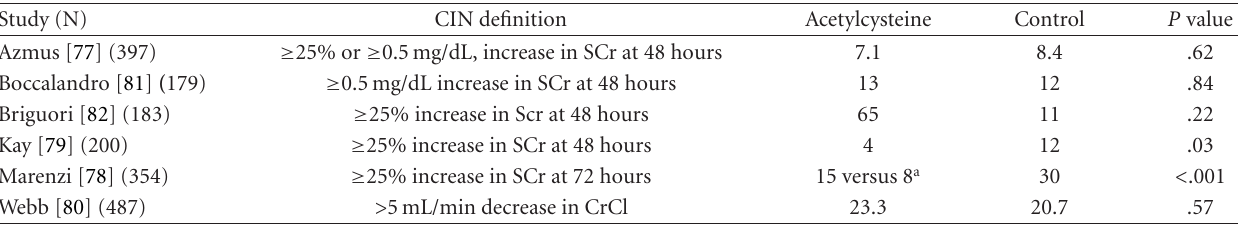
Table 4: Studies comparing acetylcysteine administration to control arm in patients undergoing coronary angiography. Study